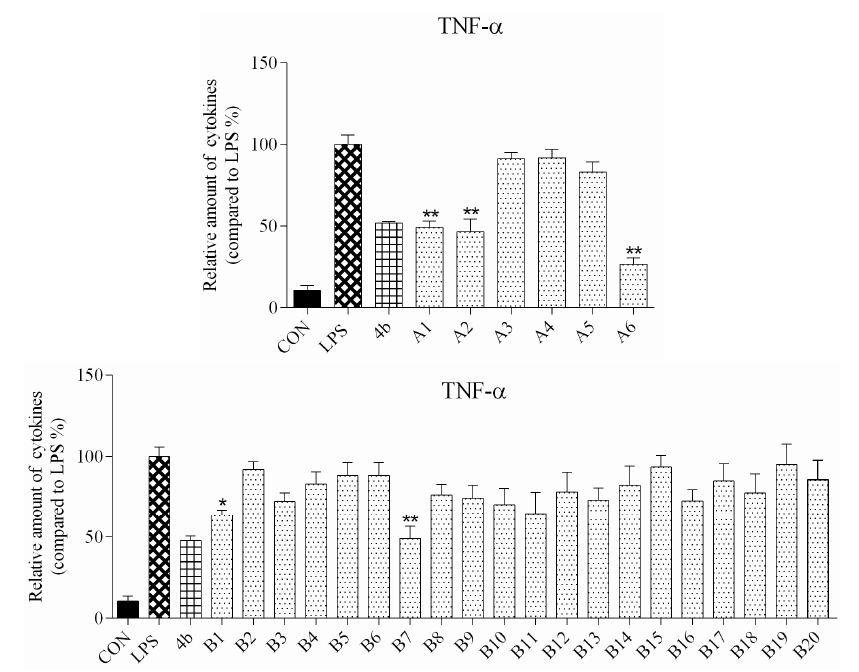
Figure 3. Relative levels of cytokine TNF- α in macrophages after treatment with compounds A1 – 6 and B1 – 20 at 10 μ M concentration as compared to LPS group and indomethacin group (*: p < 0.05; **: p < 0.01).